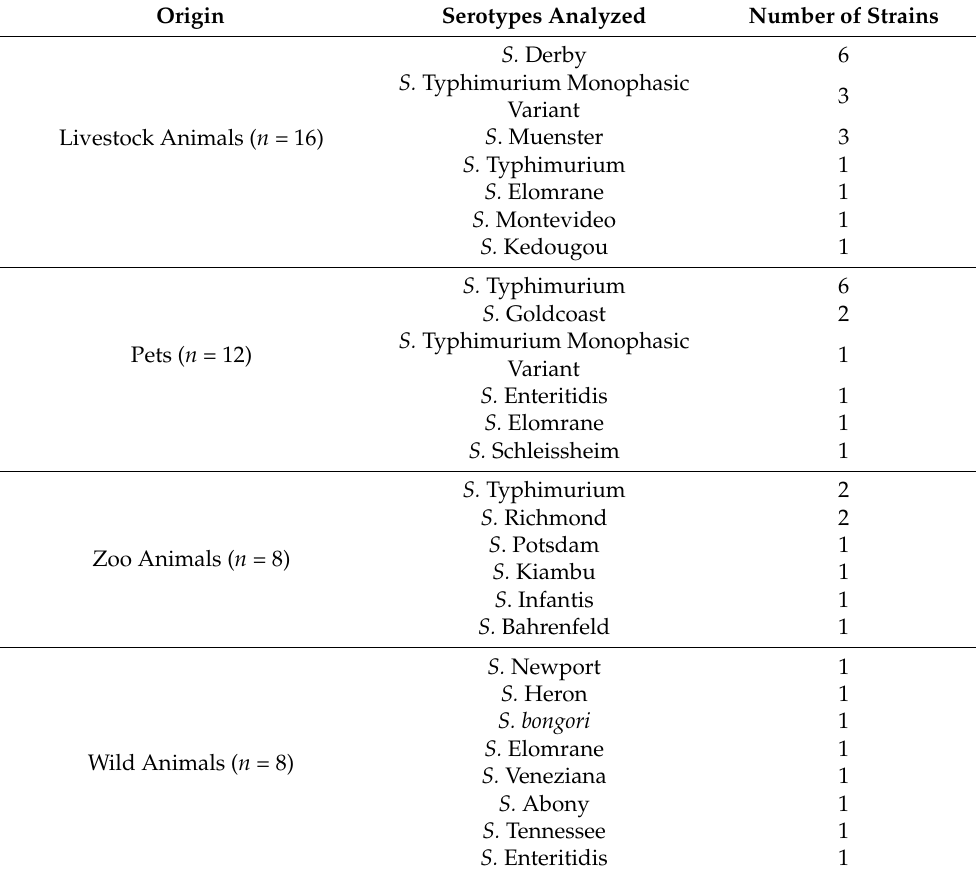
Table 1. Source and serotypes of Salmonella spp. strains